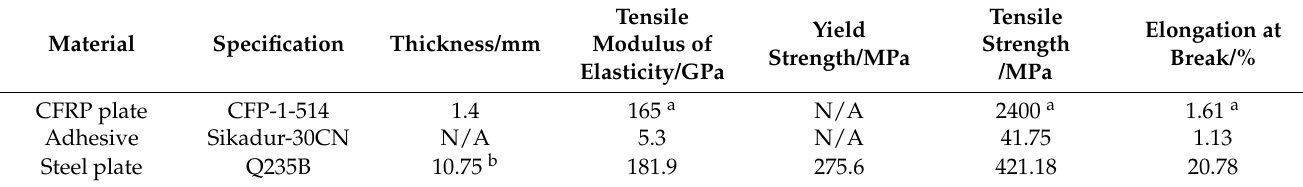
Table 2. Material